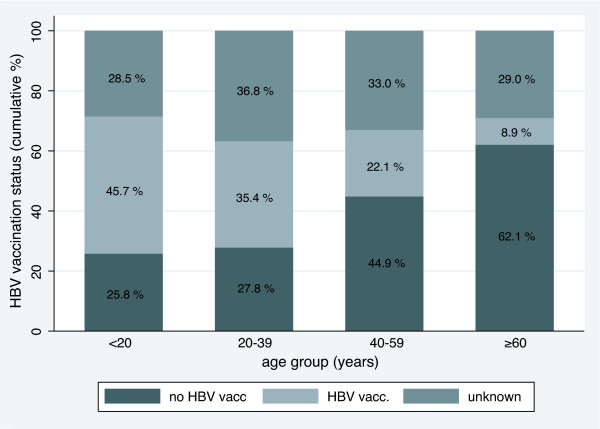
Hepatitis B vaccination status according to patient questionnaires over 4 age categories. As shown, knowledge about vaccination status does not change in relation to age, but the proportion of patients without HBV vaccination increases above the age of 40.